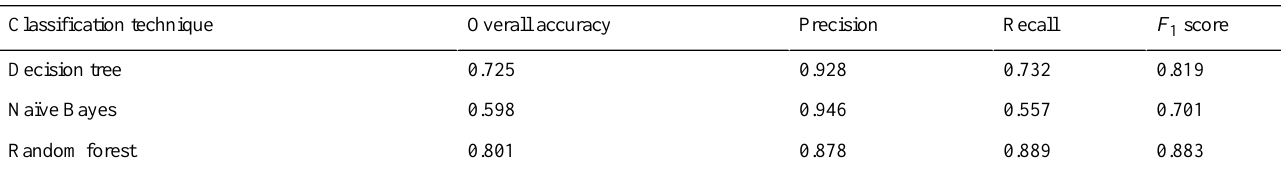
Table 5. Classification of the Repeatable Battery for the Assessment of Neuropsychological Status score performance measures when models trained using the 4 key variables: (1) age at which the participant stopped education, (2) the Timed Up and Go score, (3) the glomerular filtration rate measure, and (4) the participant’s age when applied to the evaluation data set (training set size=2152; evaluation set size=717).